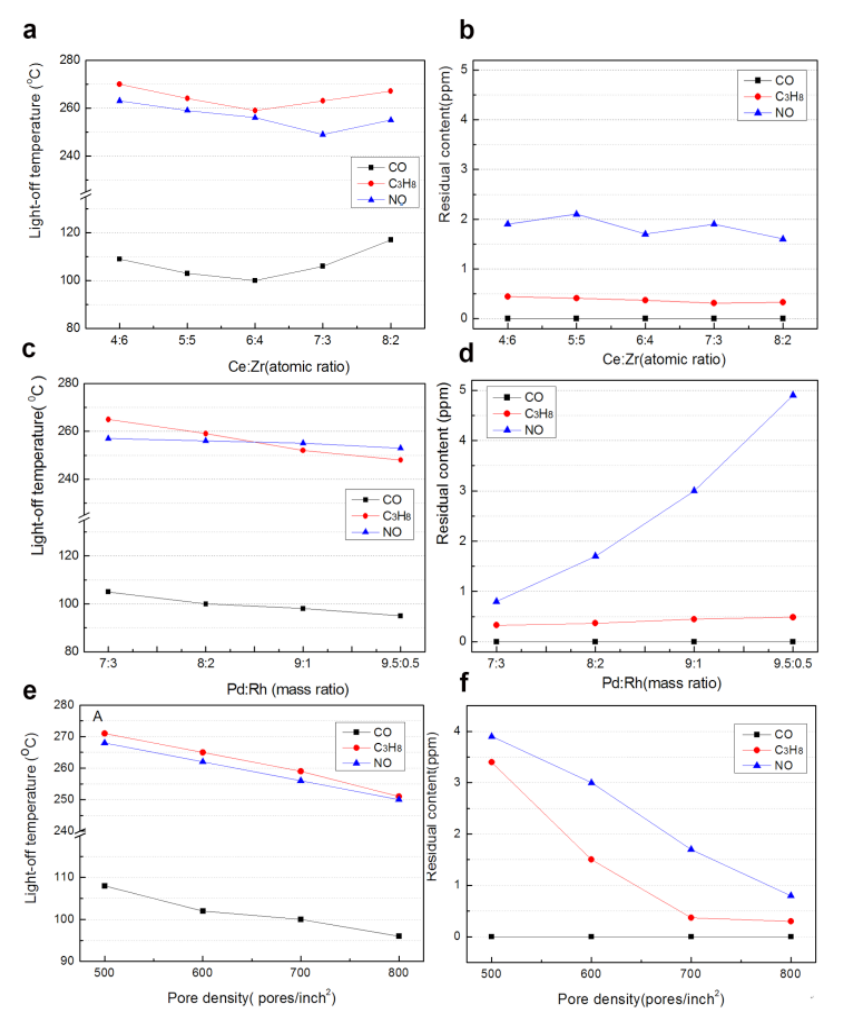
Figure 2: Effect of (a, b) Ce:Zr atom ratio, (c, d) Pd:Rh mass ratio, (e, f) pore density on light-off temperature and residual